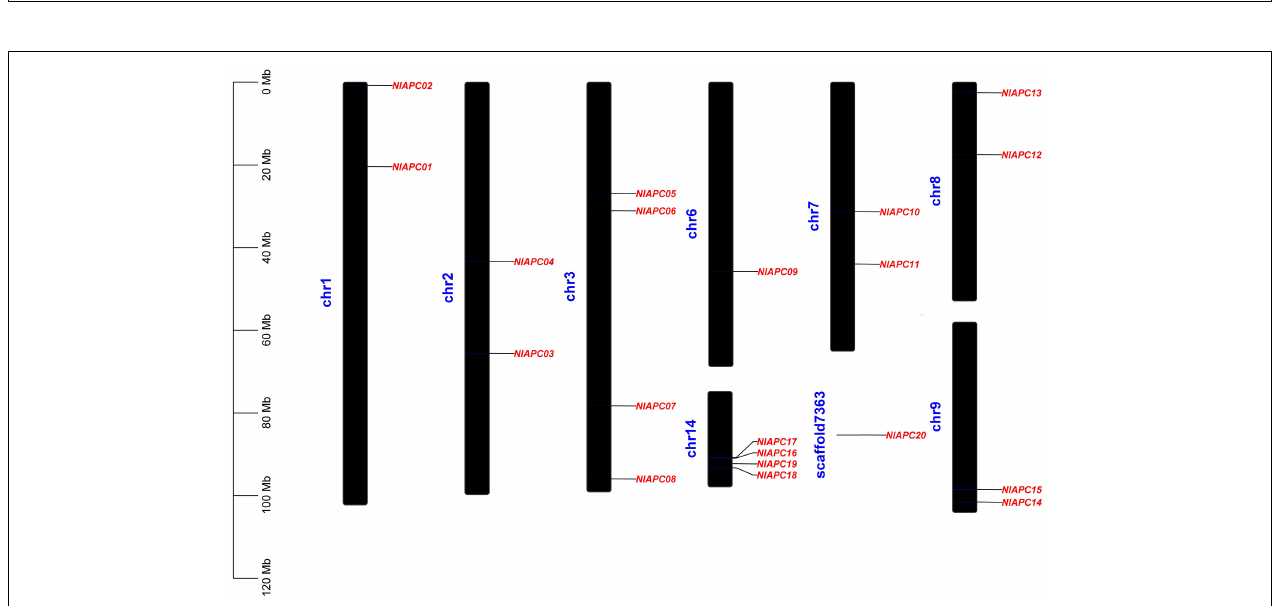
FIGURE 3 | Chromosomal location of identified BPH APC transporter genes. The diagram was constructed by TBtools (version 1.089) software according to the gene annotation information (gff3 file) of BPH genome. Chromosome length is indicated by the scale bar on the left.